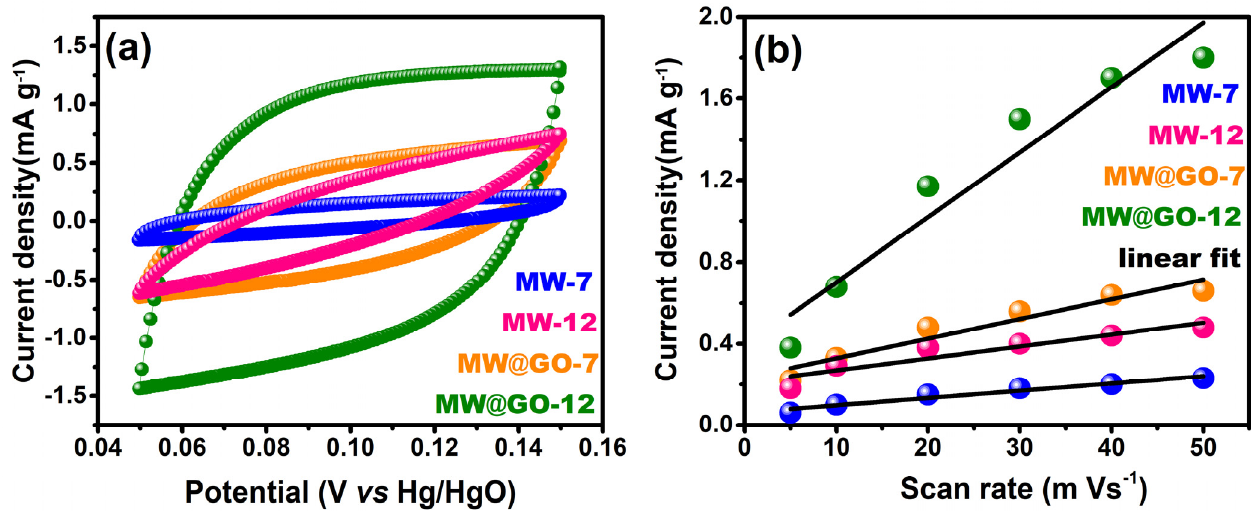
Figure 7. Comparative CV curves of the electrocatalysts for the ECSA analysis ( a ) and the corre- sponding electrochemical double-layer capacity linear fit plots of the electrocatalysts ( b ).